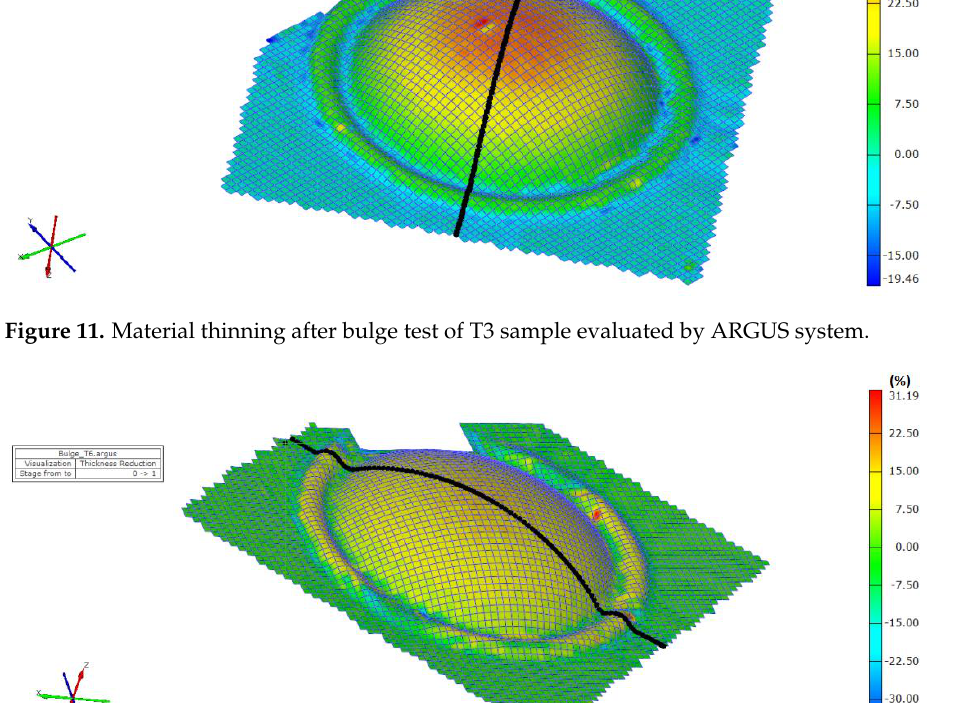
Figure 12. Material thinning after bulge test of T6 sample evaluated by ARGUS system.